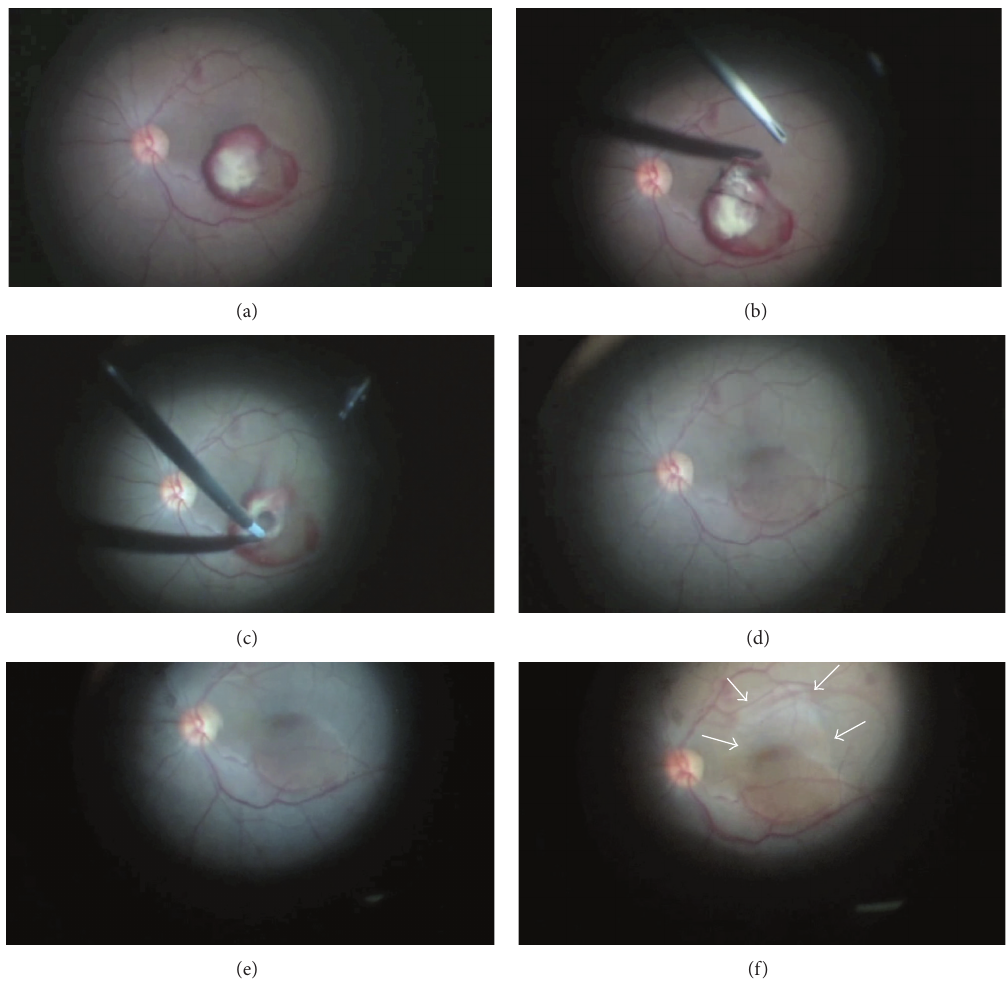
Figure 1: (a) Intact clot after posterior hyaloid peeling; (b) internal limiting membrane (ILM) peeling; (c) gentle suction of sub-ILM hemorrhagic-fibrinoid material; (d) retinal aspect after hemorrhage evacuation; (e) Brilliant Blue staining of the remnant ILM; (f) bleaching of the retinal tissue (white arrows) after enlargement of ILM peeling out of hemorrhage region edges.